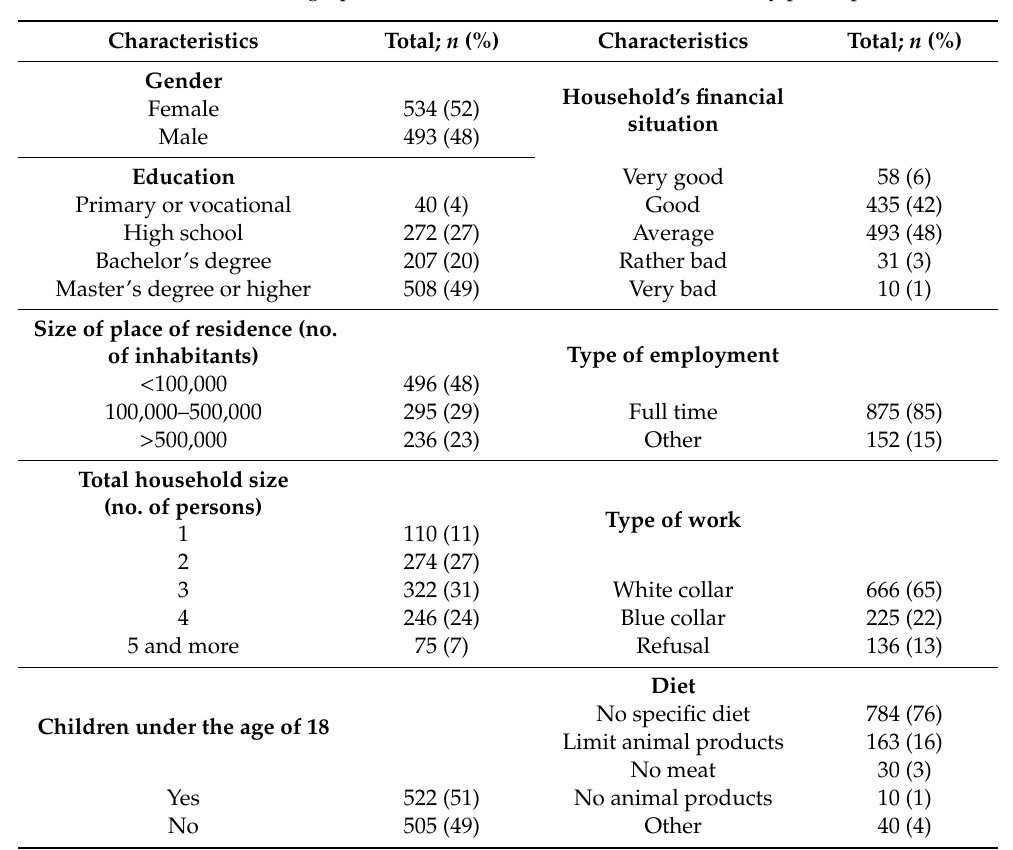
Table 1. Socio-demographic and household characteristics of survey participants.